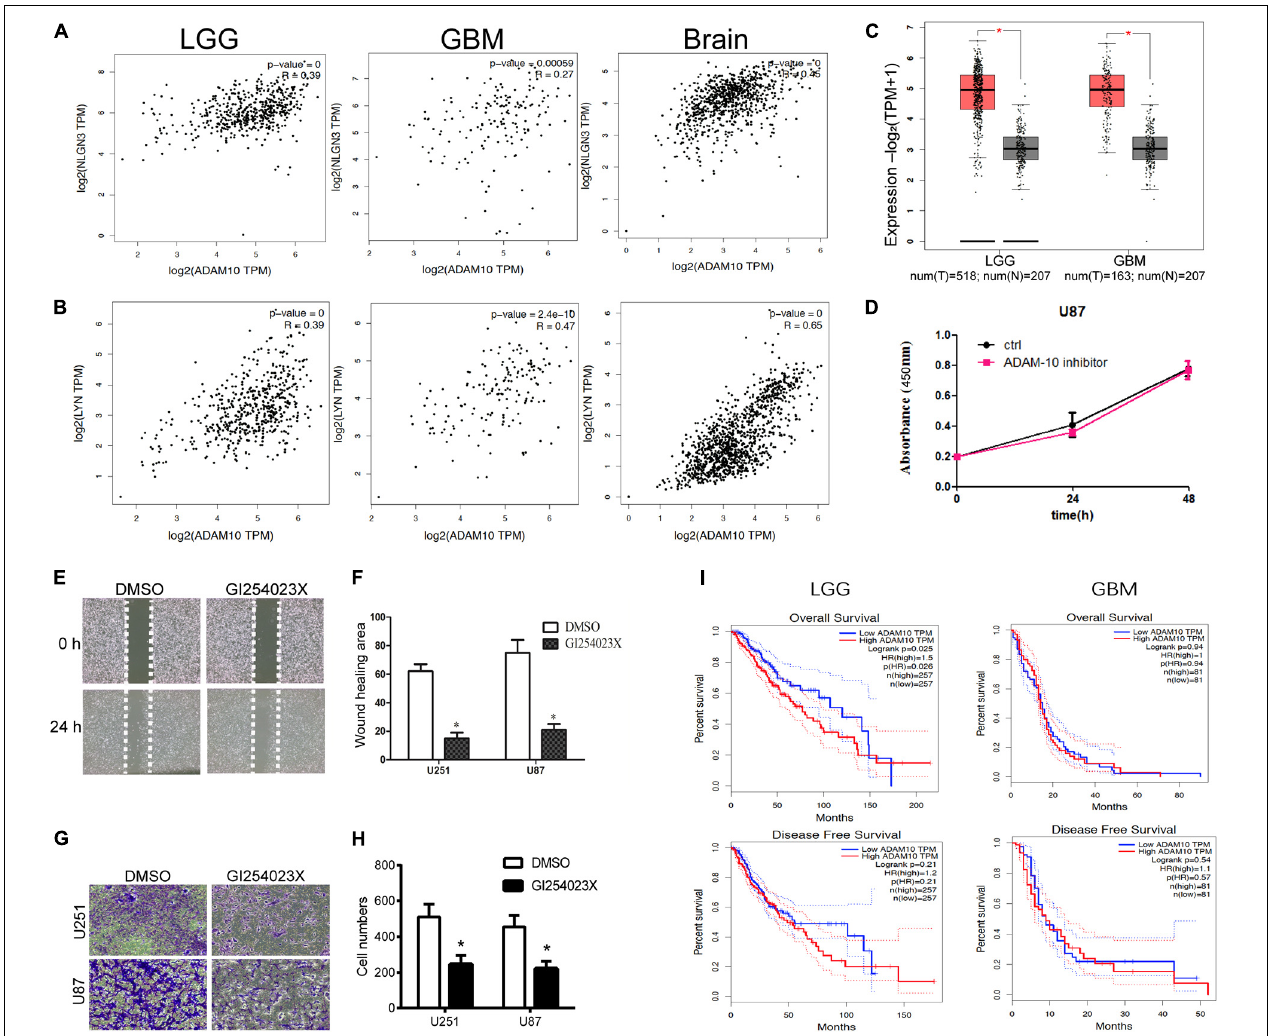
FIGURE 5 | ADAM10 promoted the migration and invasion of glioma cells. (A) Correlation analysis between expression of ADAM10 and NLGN3 in glioma and normal brain tissue was performed using GEPIA. (B) Correlation analysis between expression of ADAM10 and LYN in glioma and normal brain tissue was performed using GEPIA. (C) The expression of ADAM10 in LGG and GBM was analyzed on GEPIA. (D) U87 cells were treated with ADAM10 inhibiter, GI254023X (10 µ M), and CCK-8 assay was performed to detect the proliferation of each group of cells. (E,F) ADAM10 inhibiter, GI254023X, suppressed the migration of U87 cells. (G,H) GI254023X inhibited the invasion of U87 and U251 cells. (I) The relationship between ADAM10 and prognosis of patients with LGG and GBM was analyzed on GEPIA. * p <